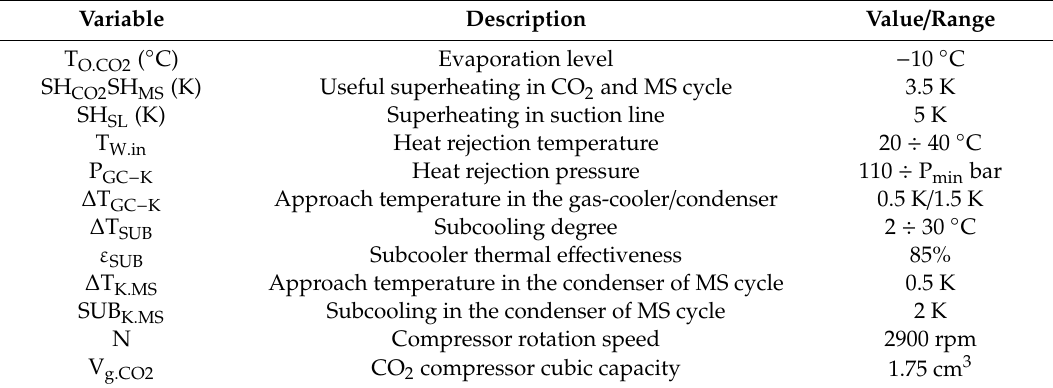
Table 7. Input data values to the computation model.